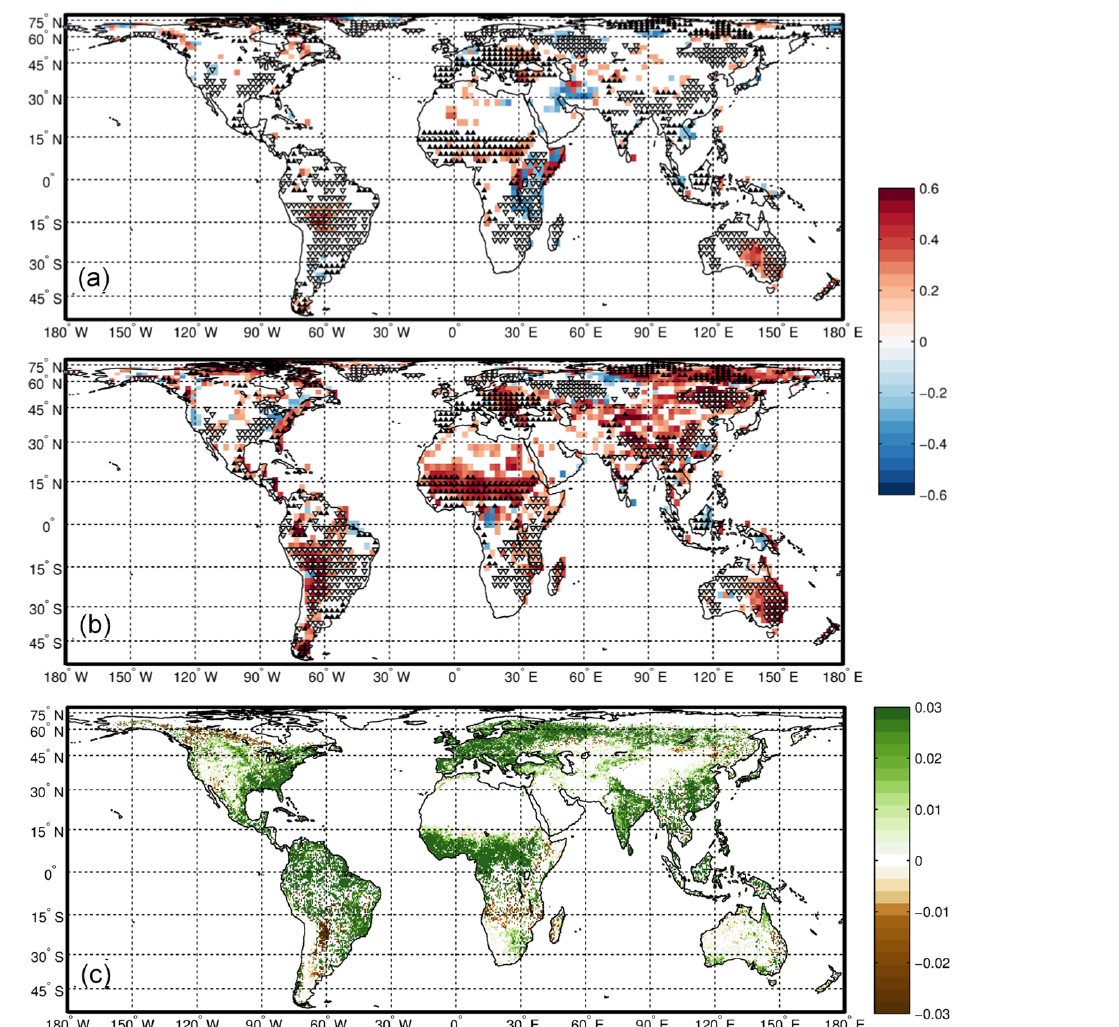
Figure 9. Point-by-point correlation of the third mode of variability in PRE forced by SM on the total field of (a) PRE forced by ET and (b) PRE forced by LAI. (c) Magnitude of the LAI change over 1982–2010, quantified using a linear model under the assumption of monotonic change. Data have been filtered using a cutoff low-pass filter at 1year − 1 frequency. Only areas where correlations (a–b) and trend (c) passed a significance test at the 5% level are shown. Black upward (white downward) triangles denote areas with positive >0.01 (negative < − 0.01) values of the third EOF of the PRE anomalies forced by the SM (Fig.